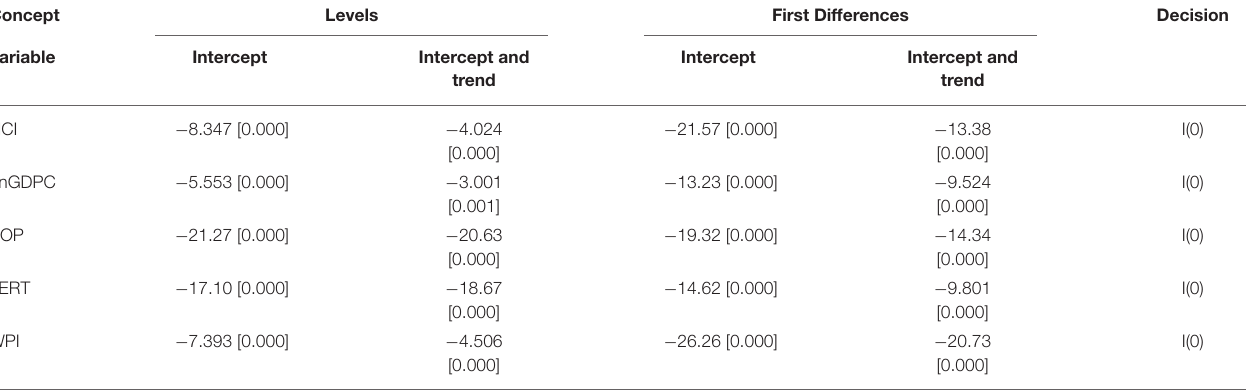
TABLE 3 | Panel unit root test